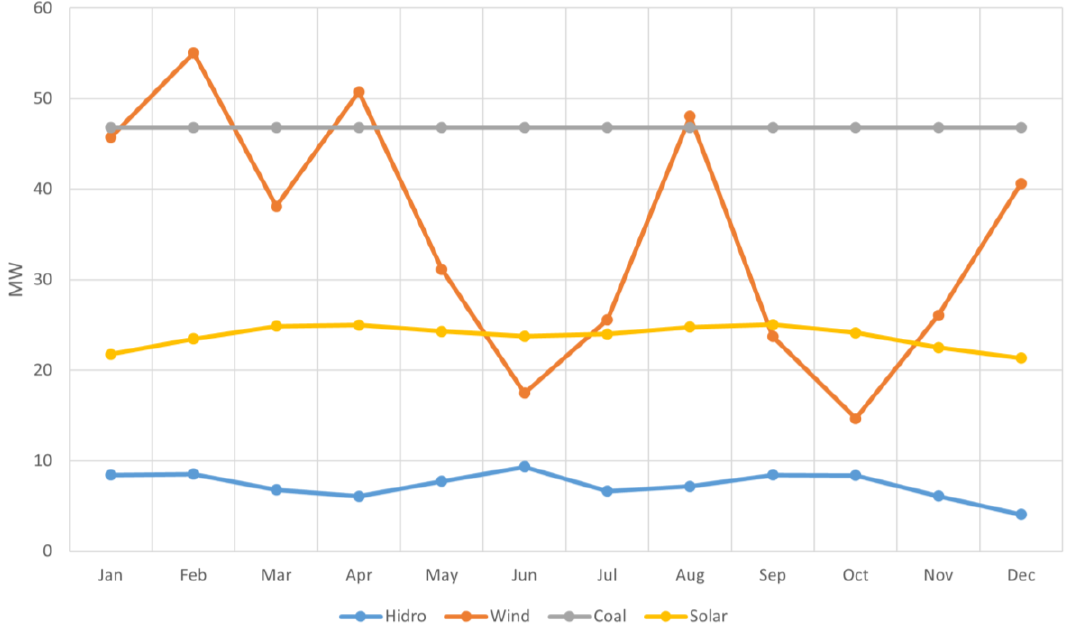
Figure 7. Monthly generation curves in the year 2021 for technologies in the southern zone.